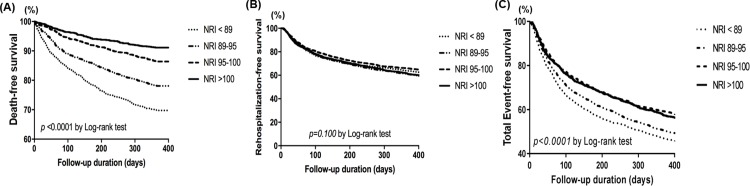
(A) Kaplan-Meier survival curves for 1-year mortality according to NRI quartiles. (B)Kaplan-Meier survival curves for rehospitalization-free survival according to NRI quartiles. (C)Kaplan-Meier survival curves for composite endpoint according to NRI quartiles. NRI = nutritional risk index.